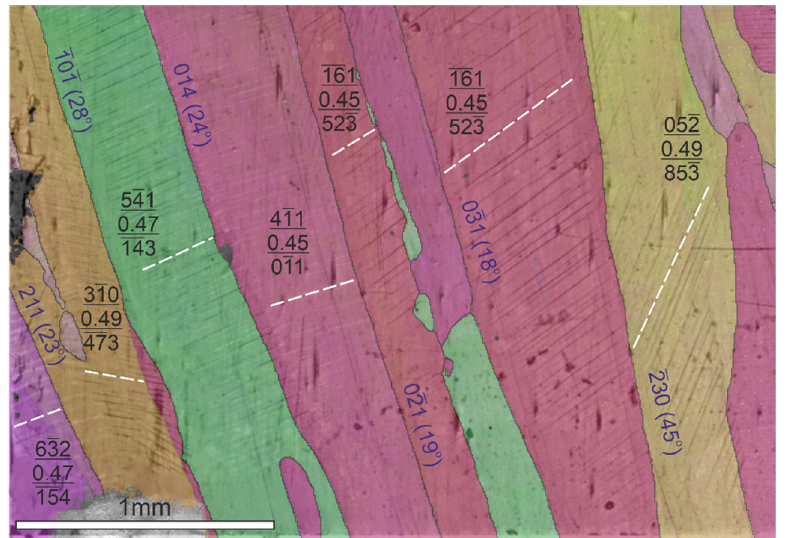
Figure 9. The fragment of face 2: the grain orientation map and the deformation relief superimposed on it (explanations in the text).